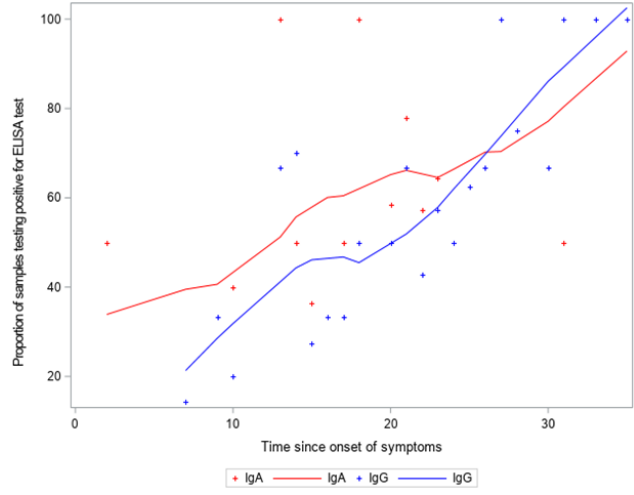
Figure 2. Proportion of samples testing positive for ELISA (Euroimmun) test: distribution of IgA + and IgG + according to time since onset of symptoms.